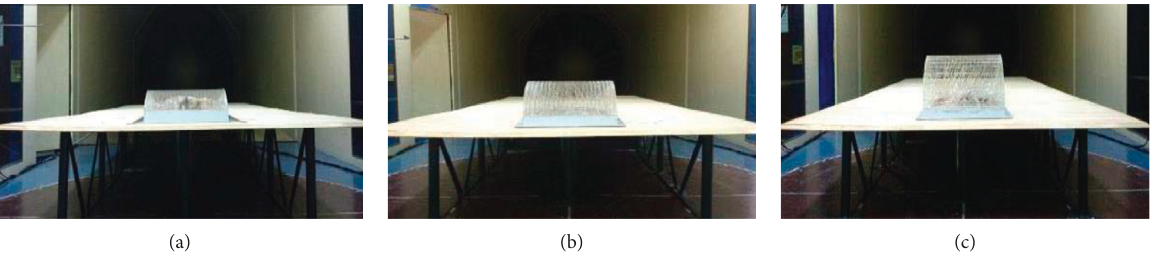
Figure 1: Experimental roof models. (a) R / S � 1/6. (b) R / S � 1/3. (c) R / S � 1/2.